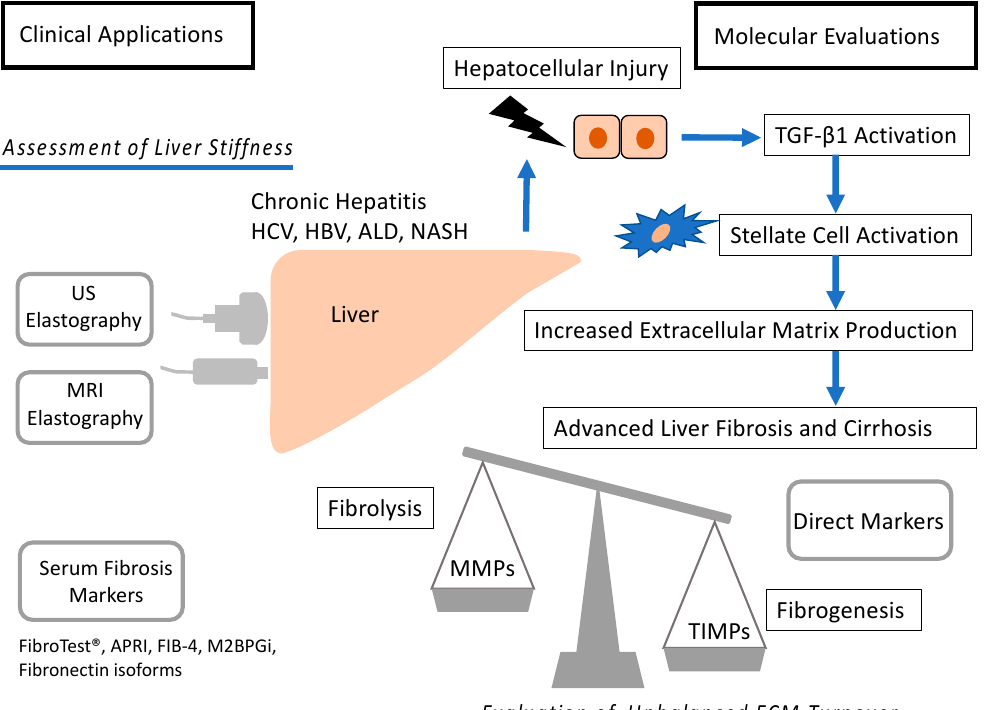
Figure 1. Molecular mechanism and diagnosis of development of liver fibrosis. Hepatocellular injury causes TGF- β 1 activation. In turn, TGF- β 1 activates hepatic stellate cell and increases ECM production, causing liver fibrosis and cirrhosis. The development is depending on the balance between fibrolysis and fibrogenesis. ECM turnover is controlled by MMPs and TIMPs. Liver fibrosis can be assessed by elastography and serum markers such as aspartate aminotransferase (AST) to platelet ratio index (APRI), FIB-4, and Mac-2 binding protein glycosylation isomer (M2BPGi). US, ultrasound; MRI, magnetic resonance imaging; HCV, hepatitis C virus; HBV, hepatitis B virus; ALD, alcoholic liver disease; NASH, nonalcoholic steatohepatitis; APRI, aspartate aminotransferase to platelet ratio index; M2BPGi, Mac-2 binding protein glycosylation isomer; MMPs, matrix metalloproteinase; TIMPs, tissue inhibitors of metalloproteinases; TGF- β 1, transforming growth factor β 1.